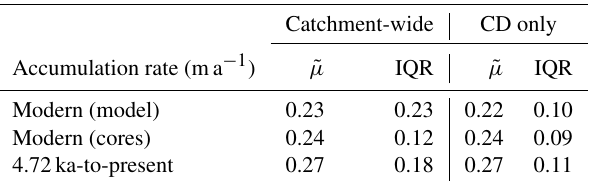
Table 2. Summary statistics for the modern (modelled and obser- vational) and 4.72ka-to-present ice-equivalent accumulation rates at the catchment-scale and over the Amundsen–Weddell–Ross Di- vide (abbreviated CD for Central Divide here). Values for the Amundsen–Weddell–Ross Divide are for all points that fall within 100km of either side of the divide (see dashed line in Fig. 4). ˜ µ refers to the median and IQR represents the interquartile range cal- culated by computing the difference between the 75th and 25th per- centiles. Note that the values provided in the text represent the me- dian relative change from the cell-by-cell change between each grid (Fig. 4), rather than the relative change of the median values pro- vided here. Catchment-wide CD only Accumulation rate (ma − 1